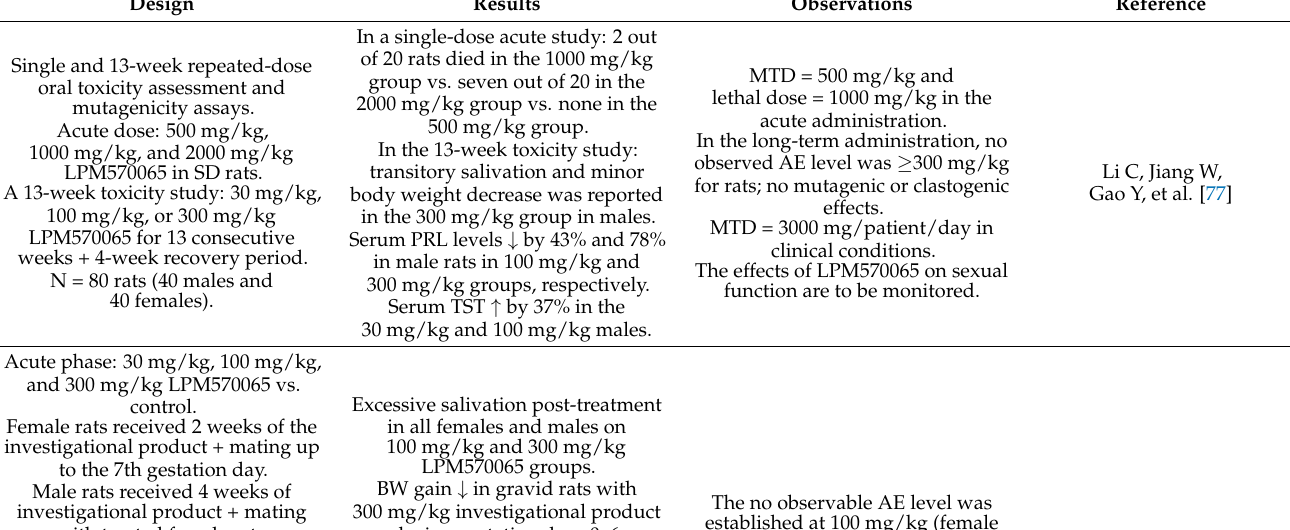
Table 1. Summary of the preclinical studies focused on